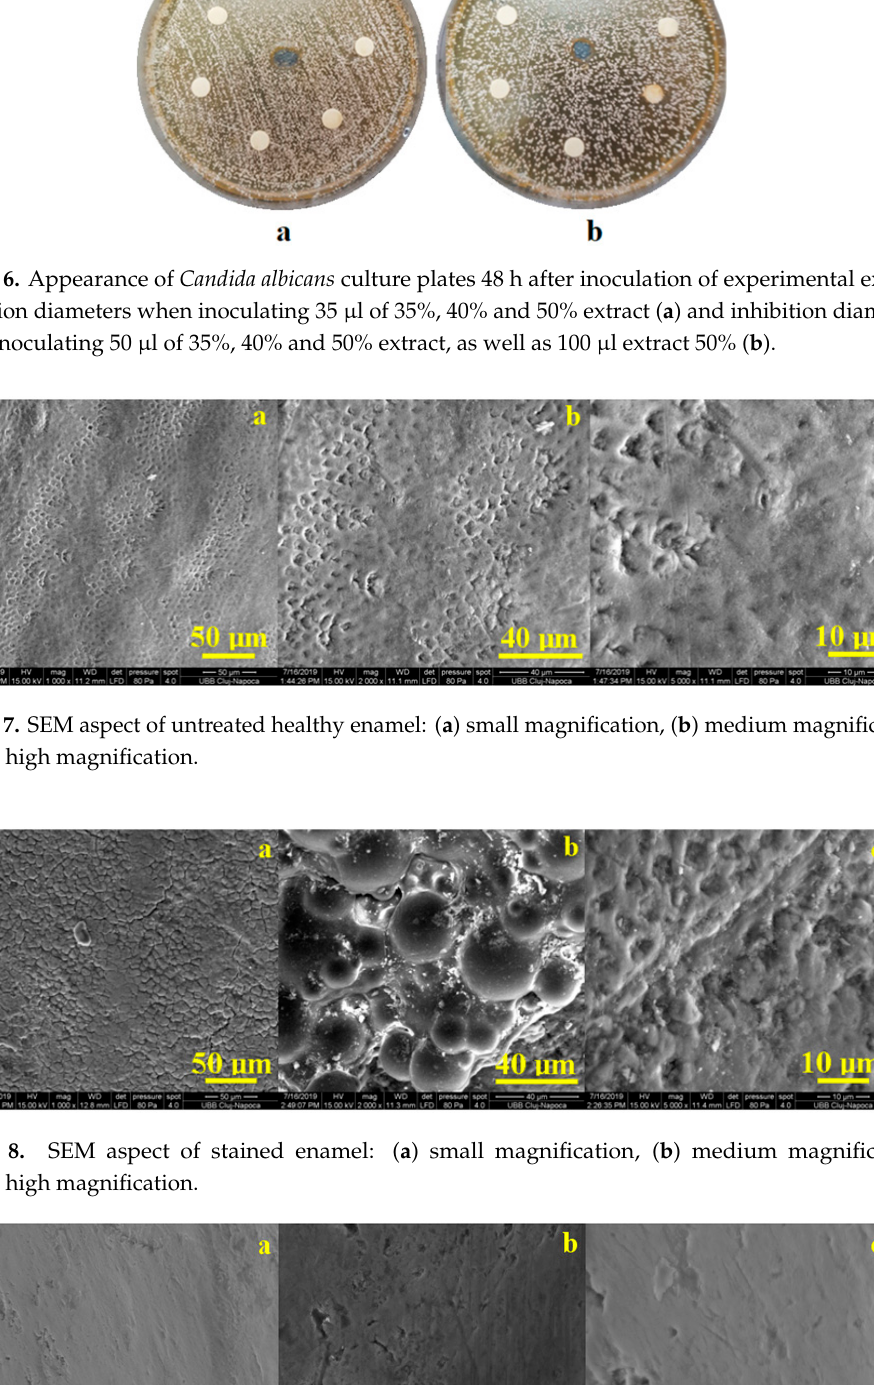
Figure 8. SEM aspect of stained enamel: ( a ) small magnification, ( b ) medium magnification, and ( c ) high magnification.